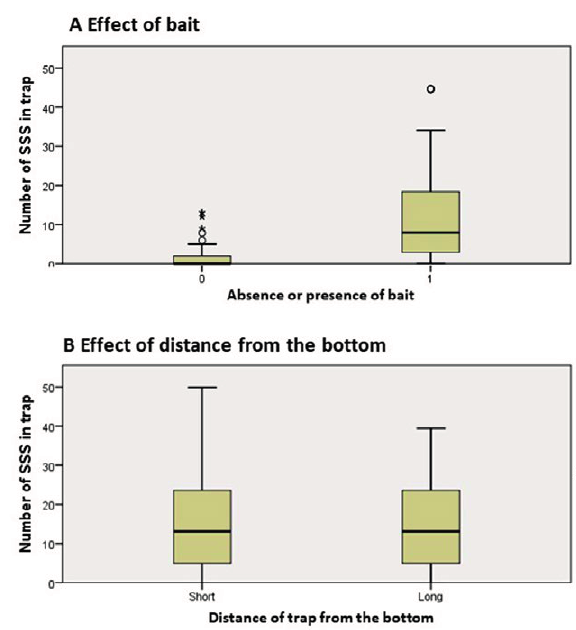
Fig. 3. – Box-plots representing the number of Plesionika edward- sii in individual traps as a function of: presence or absence of bait (n_present=160, n_absent=33) (A) and distance of the trap from the sea floor (B), long distance about 1.5 m, short distance about 0.5 m (n_long=91,